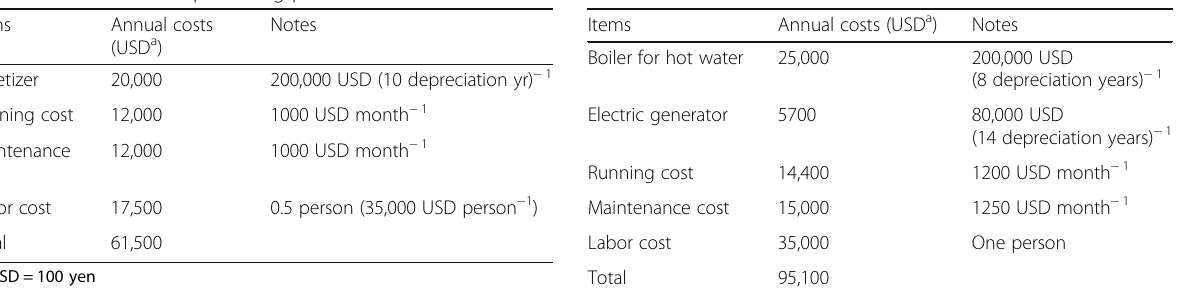
Table 1 Cost of the ash pelletizing process